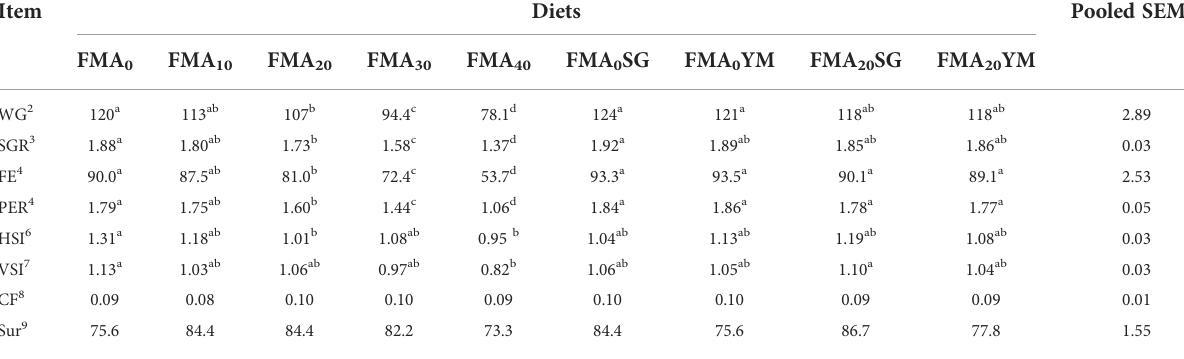
TABLE 2 Growth performance of juvenile Japanese eel fed with the experimental diets for 8 weeks 1